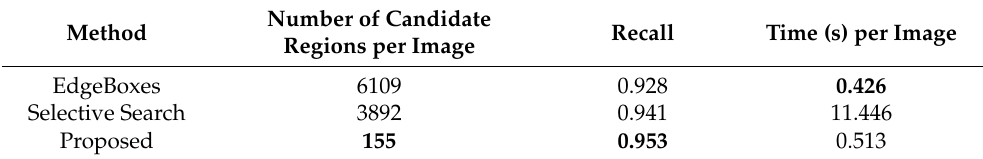
Table 2. The results of the three different region proposal